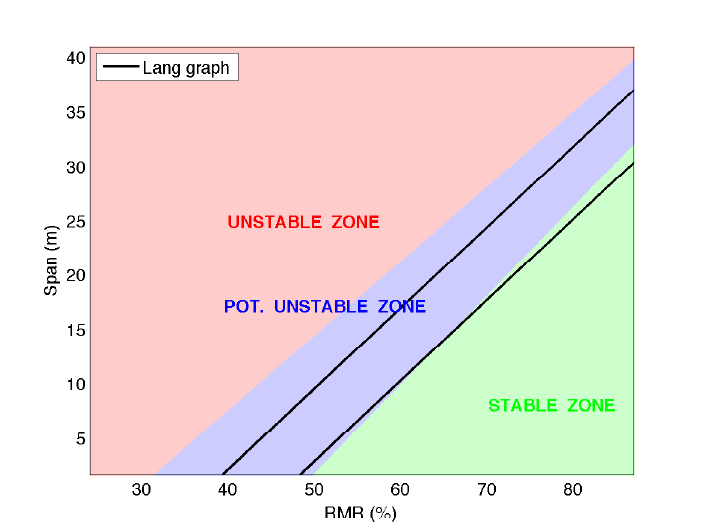
Figure 6. Critical span graph: comparison: SVM (three groups) vs. Lang.